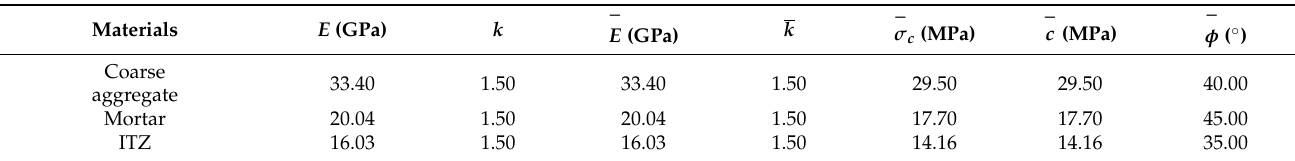
Table 1. Parameters of